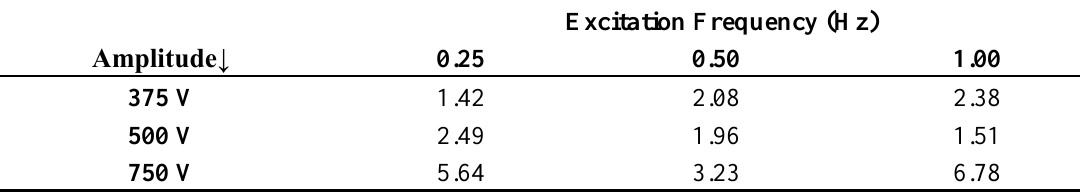
Table 8. Performance index for different input